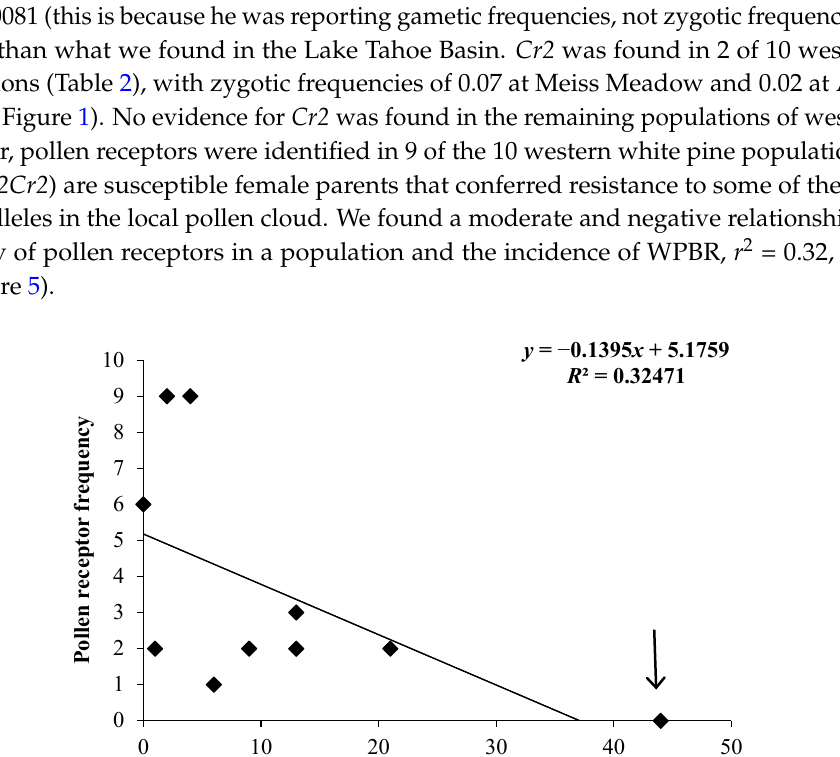
Figure 4. Genetic and trait patterns for western white pine populations from the Lake Tahoe Basin.